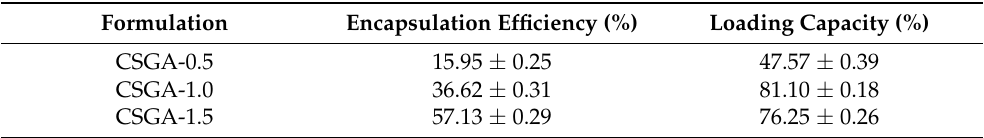
Table 2. Mancozeb encapsulation and loading capacity of CSGA